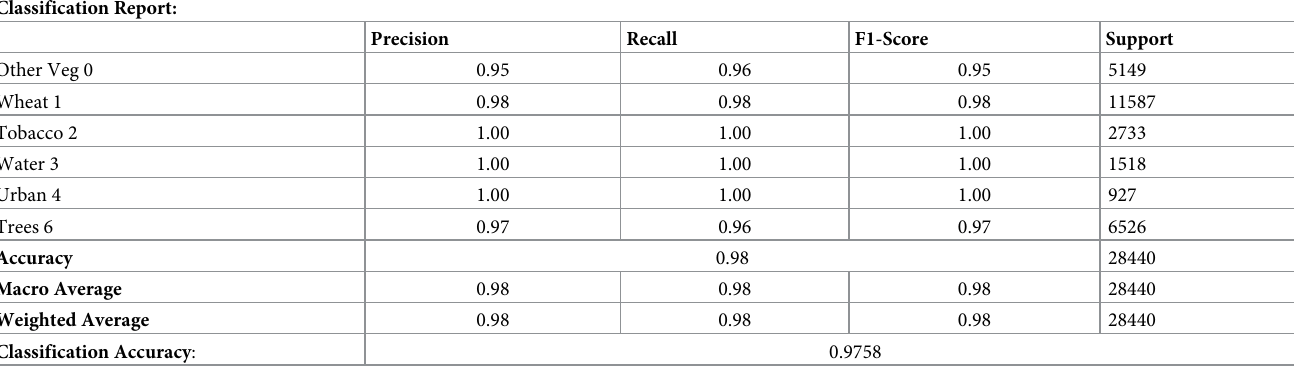
Table 8. Classification report explaining performance of ConvLSTM over test